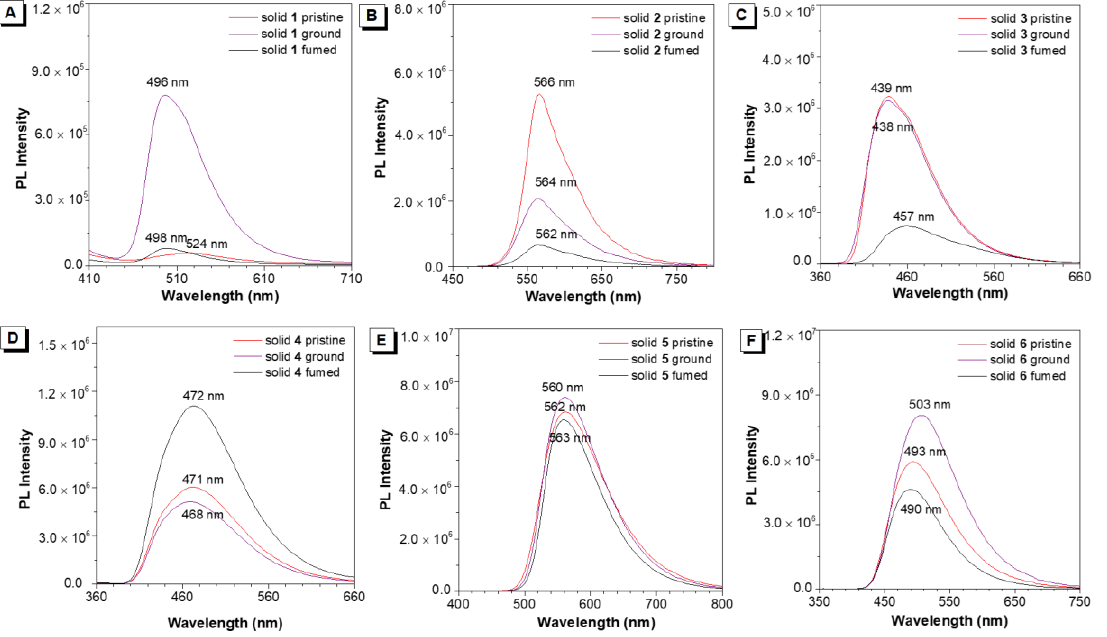
Figure 2. PL spectra of molecules 1 – 6 as pristine and ground solids. Molecule 1 (Excitation wavelength = 389 nm), molecule 2 (Excitation wavelength = 425 nm), molecule 3 (Excitation wavelength = 320 nm), molecule 4 (Excitation wavelength = 326 nm), molecule 5 (Excitation wavelength = 365 nm), molecule 6 (Excitation wavelength = 334 nm).